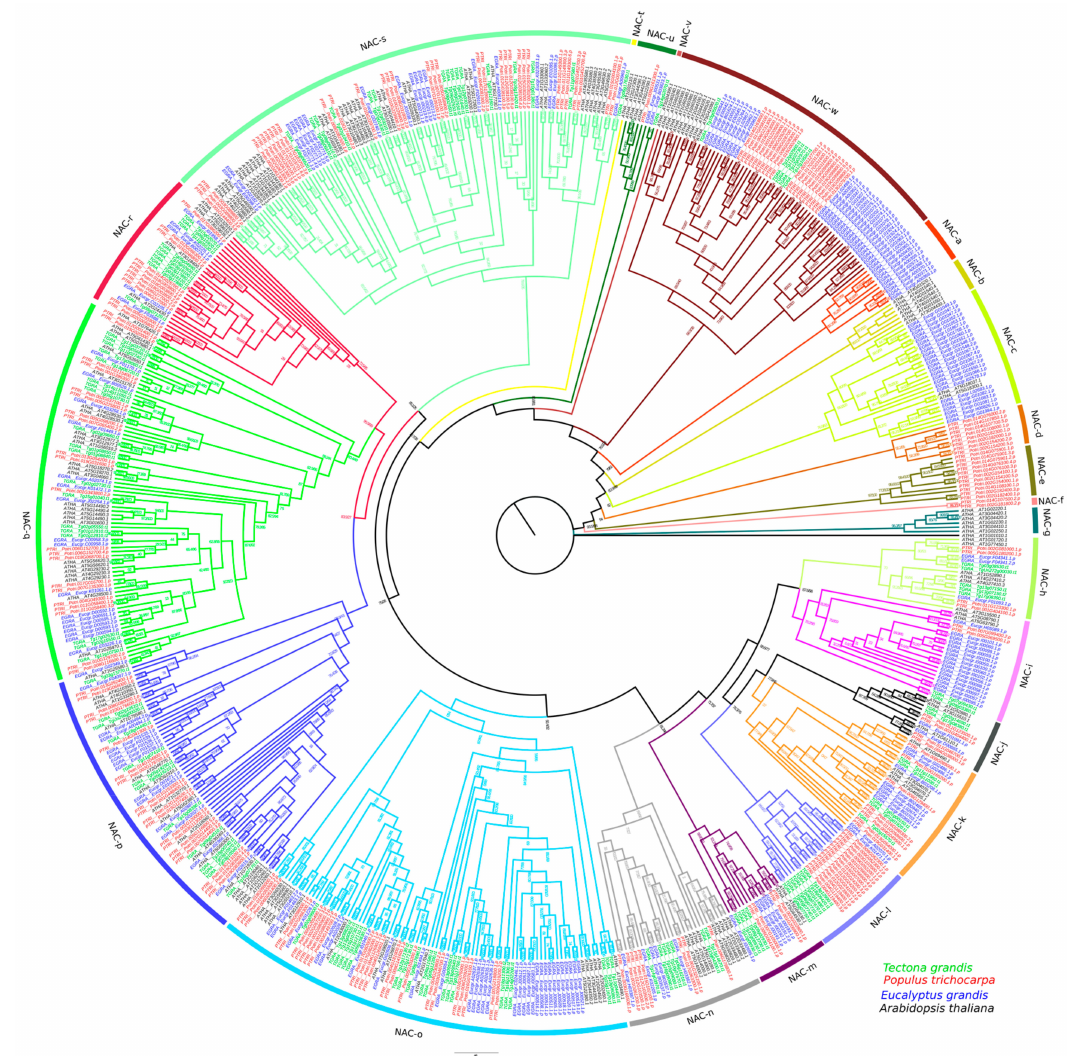
Figure 1. Maximum-likelihood phylogenetic tree rooted of NAC domain proteins of T. grandis , Populus , Arabidopsis, and Eucalyptus . The NAC family proteins were clustered in 23 distinct clades (NAC-a–NAC-w). Members of T. grandis (116), Populus (196), Arabidopsis (153), and Eucalyptus (190) NAC protein family were denoted with green, brown, black, and blue letters, respectively. Bootstrap values are described in the branch